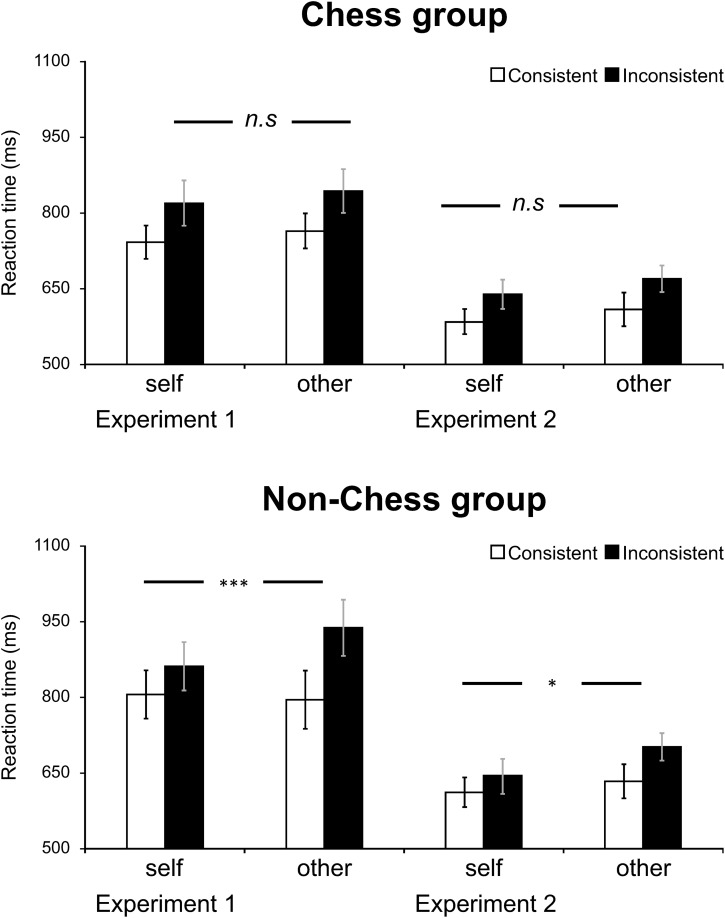
Mean response time for each experimental condition in Experiment 1 and Experiment 2. Symbols indicate significance level (∗∗∗p < 0.001; ∗∗p < 0.01; ∗p < 0.05; n.s = non significant).